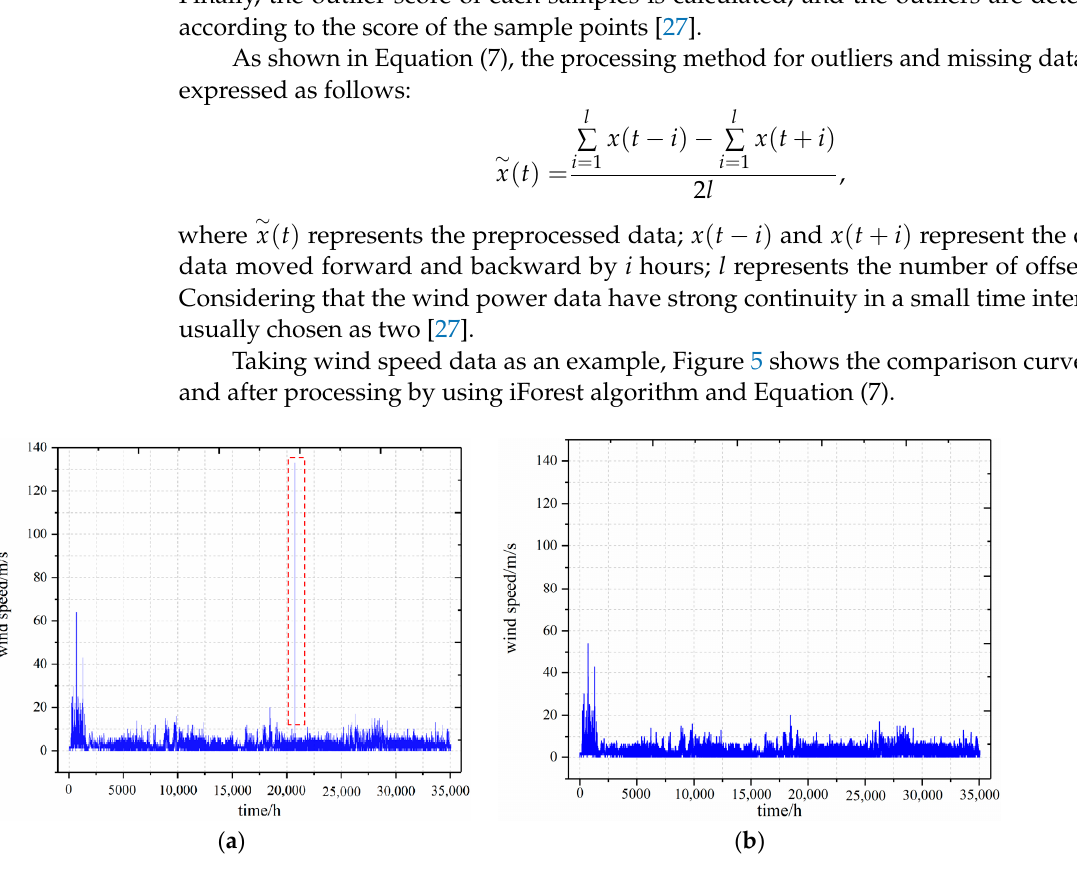
Figure 5. Sample of raw wind speed data curve and the cleaned data curve: ( a ) raw wind speed data curve; ( b ) The cleaned wind speed data curve.